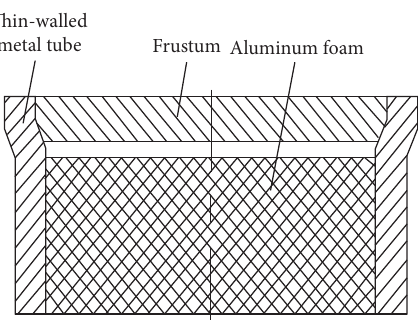
Figure 7: Structure of buffer No.